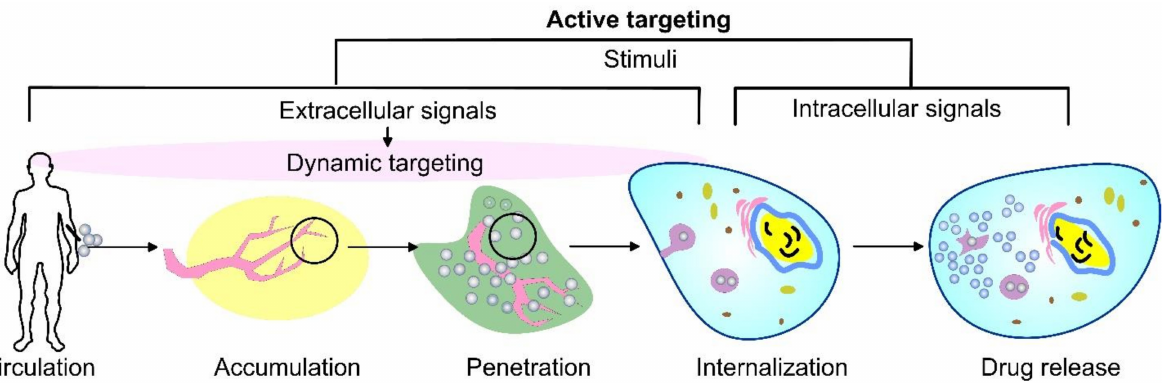
Figure 2. A schematic representation of cancer drug delivery by stimuli-responsive vehicles. De- pending on the area of activation, the stimuli can be divided into extracellular signals that focus on dynamic targeting during circulation, accumulation, penetration, and internalization, as well as intracellular